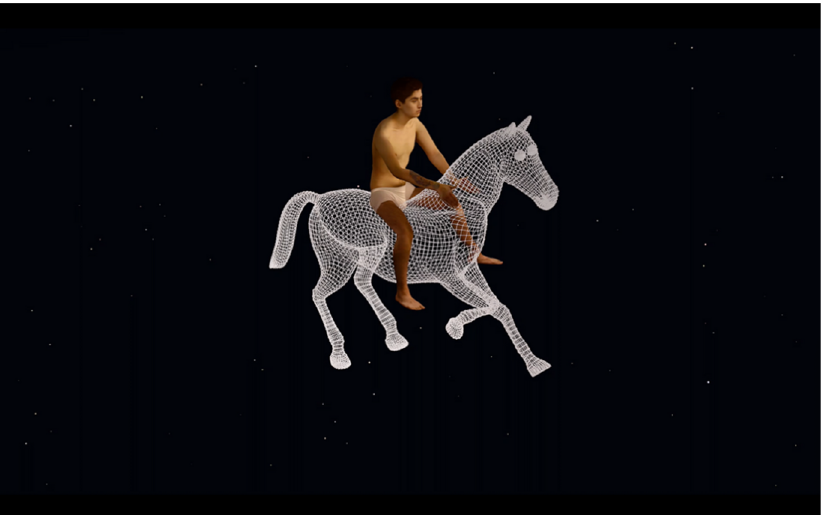
Figure 8. Anvar Musrepov, still from the video loop Jigitovka (2016). Image courtesy of the